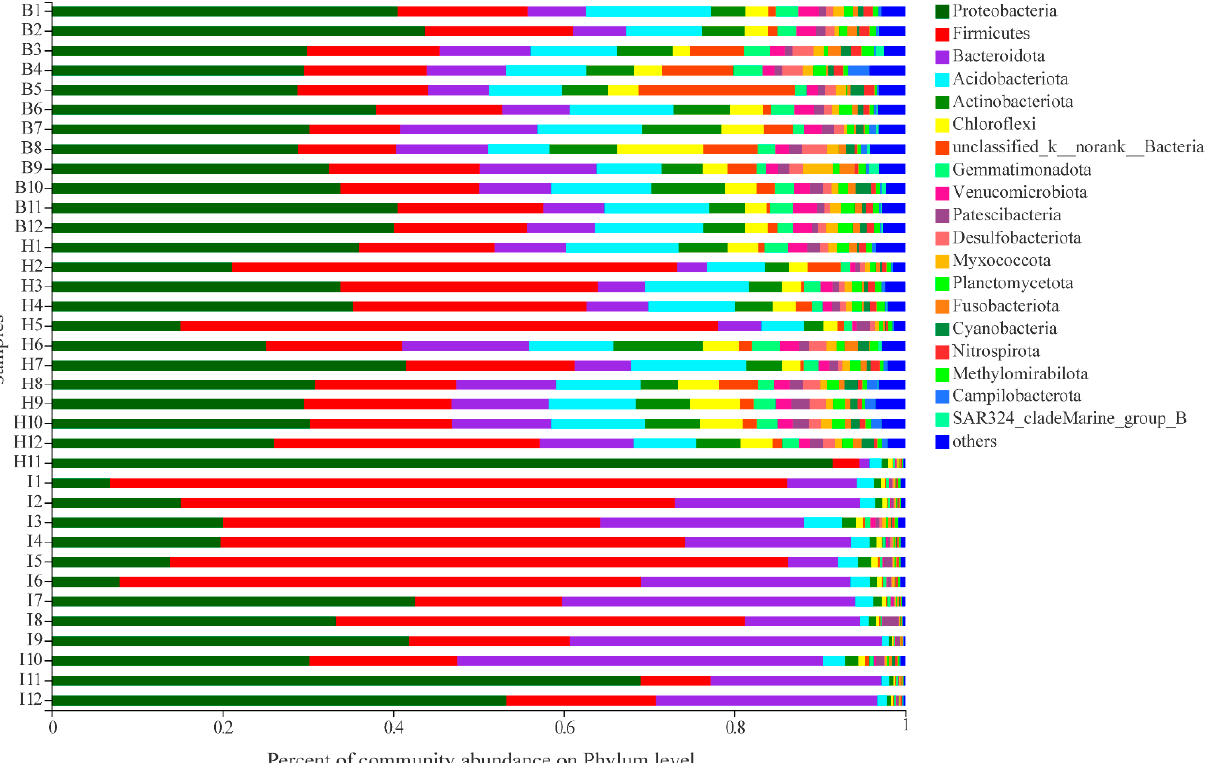
Figure 3. Distribution of the bacterial communities in all thirty ‐ six samples at the phylum level. B: hemolymph (B1–B12); H: hepatopancreas (H1–H12); I: intestine